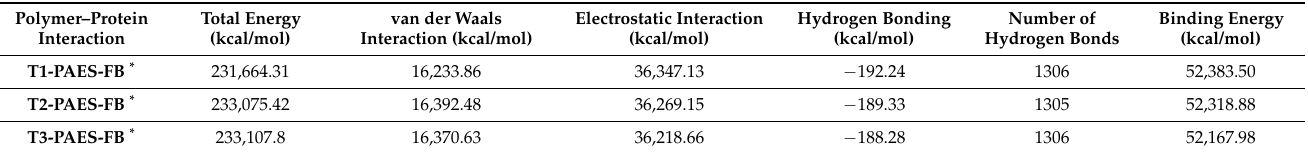
Figure 5. Schematic illustration (left) and MD capture (right) of the fibrinogen and polymeric mem- brane model ( a ) far from each other and ( b ) interacting with each other.